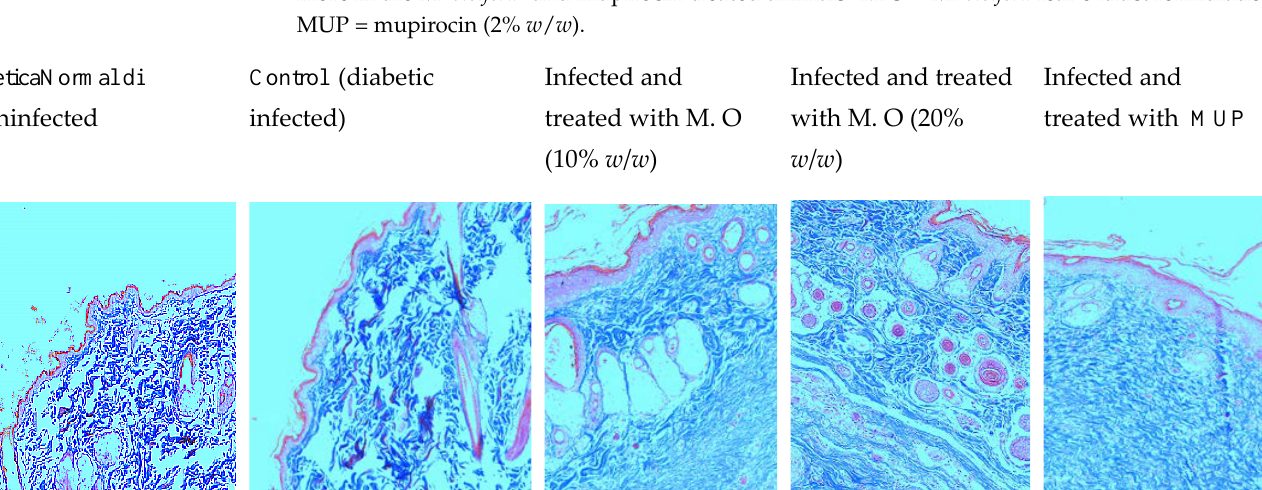
Figure 6. Histology of skin from diabetic animals infected with MRSA stained with Masson’s trichrome stain (100 × ). Photomicrographs showing skin tissue stained with Masson’s trichrome stain. The blue color indicates collagen fibers. The number of fibers was more in the treated groups compared to the control group. M.O = M. oleifera leaf extract formulation, MUP = mupirocin (2% w / w ).